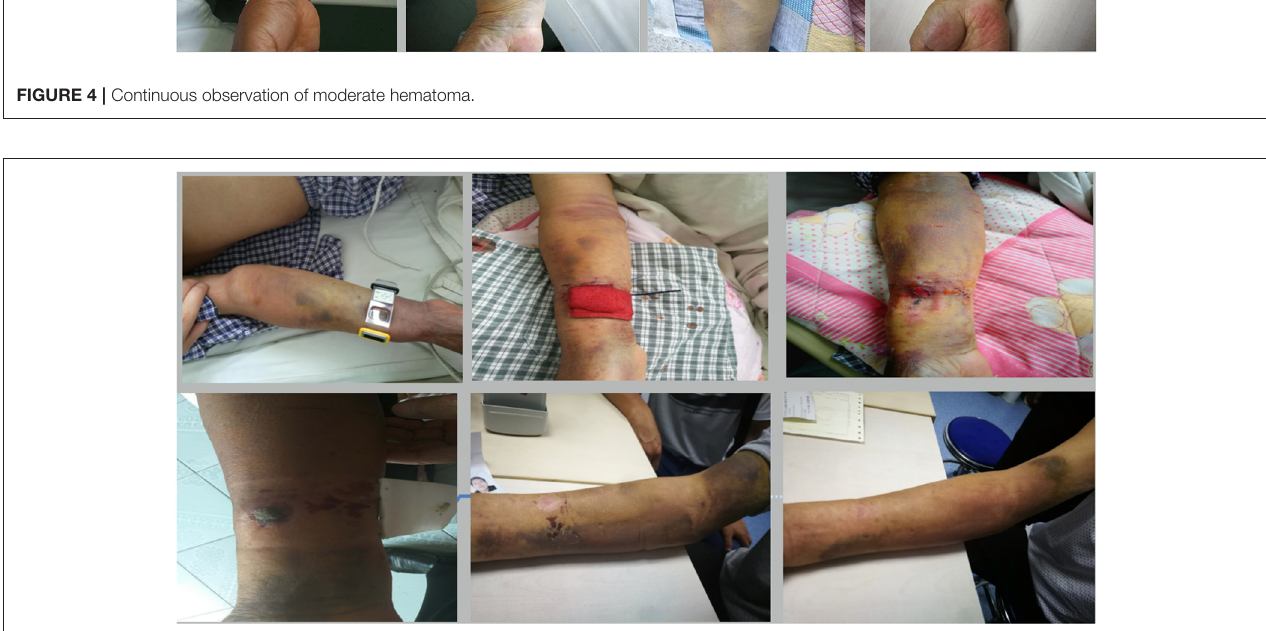
FIGURE 5 | Continuous observation of severe hematoma.